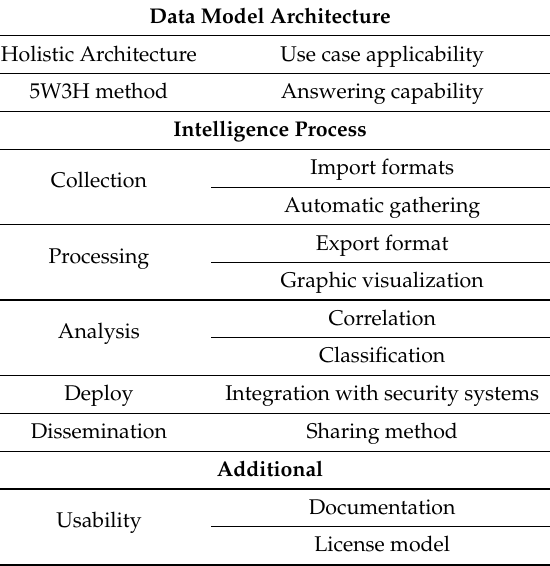
Table 3. Evaluation criteria for CTI